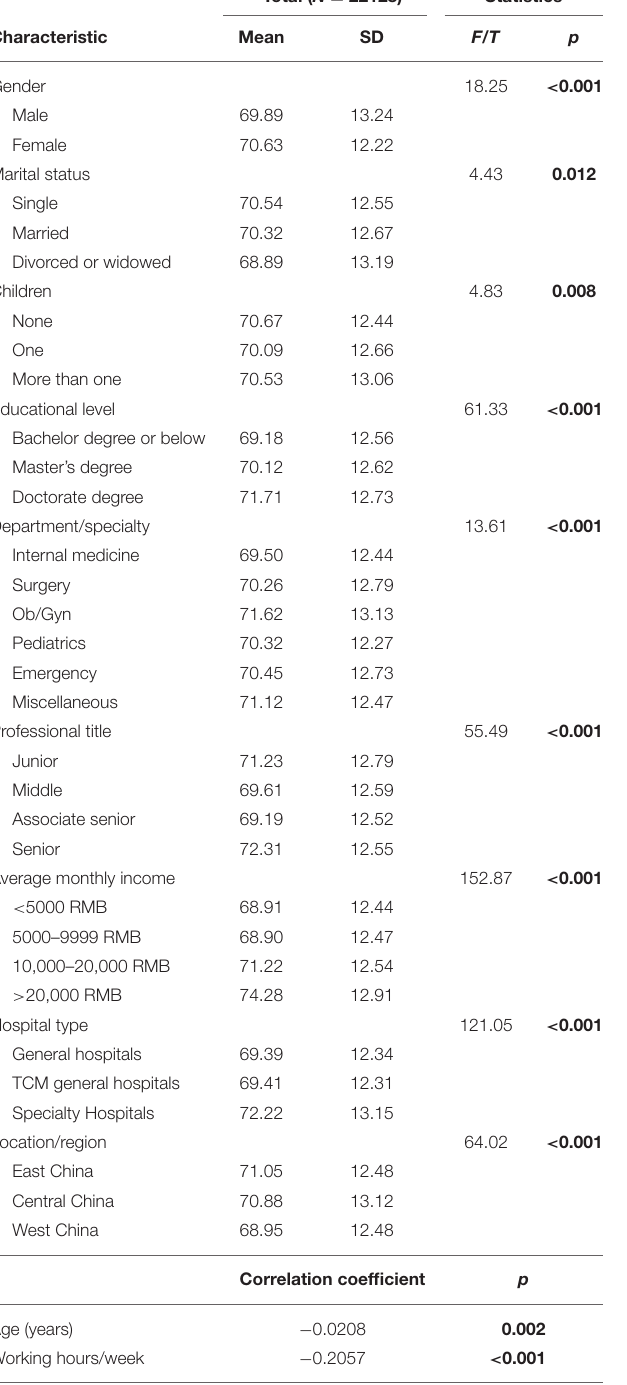
TABLE 3 | Multi-level linear regression examining factors associated with MSQ. Statistics